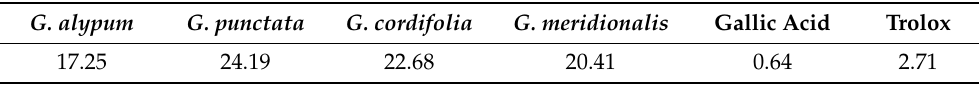
Table 5. DPPH radical scavenging activity of G. alypum , G. punctata , G. cordifolia and G. meridionalis methanolic aerial parts extracts expressed as IC 50 value ( µ